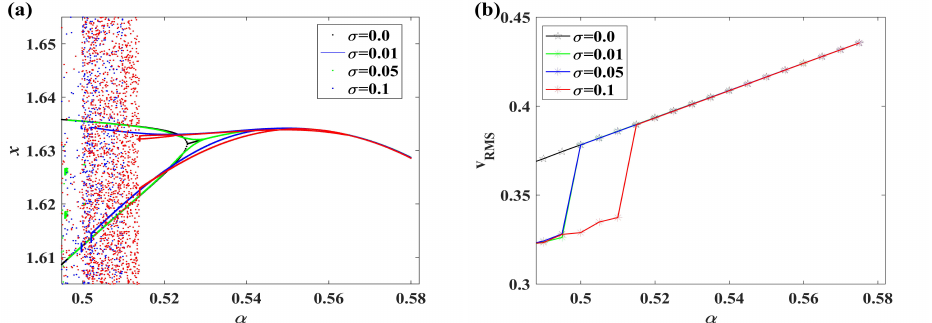
Figure 11. EMR for 0.5 < α < 0.58 under the stochastic intensities σ = 0.0, σ = 0.01, σ = 0.05 and σ = 0.1. ( a ) Bifurcation diagrams; ( b ) RMS